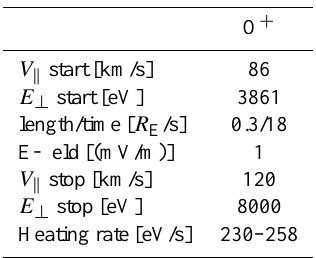
Table 2. Backward test particle calculation. We have used 1v = (qE ⊥ /m)1t to calculate the energy change.